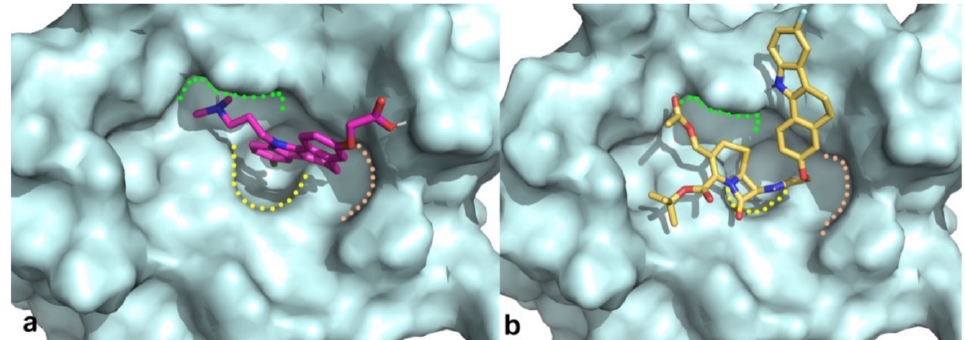
Figure 2. Binding modes obtained by docking results of compounds RM58 ( a ) and RM37 ( b ) into Table 1. Structures, in-house database codes, and MDM2 inhibitory activity of compounds selected MDM2 binding site. Protein is shown as cyano surface, whereas RM58 and RM37 are shown as from VS. a Evaluated by in vitro p53-p/HDM2 binding assay, as described in Costa et al., 2013 magenta and golden sticks, respectively. Leu26, Trp23, and Phe19 subpockets are shown with green, yellow, and pink dashed lines, respectively.